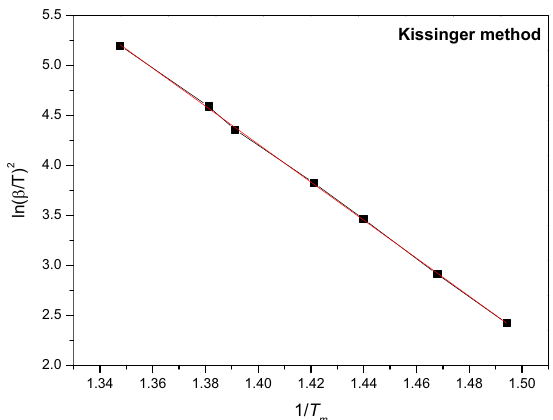
Figure 5. Kinetic study plot [ln( b / T m 2 ) vs. 1/ T m ] of keyboard plastic waste using Kissinger method at a single heating